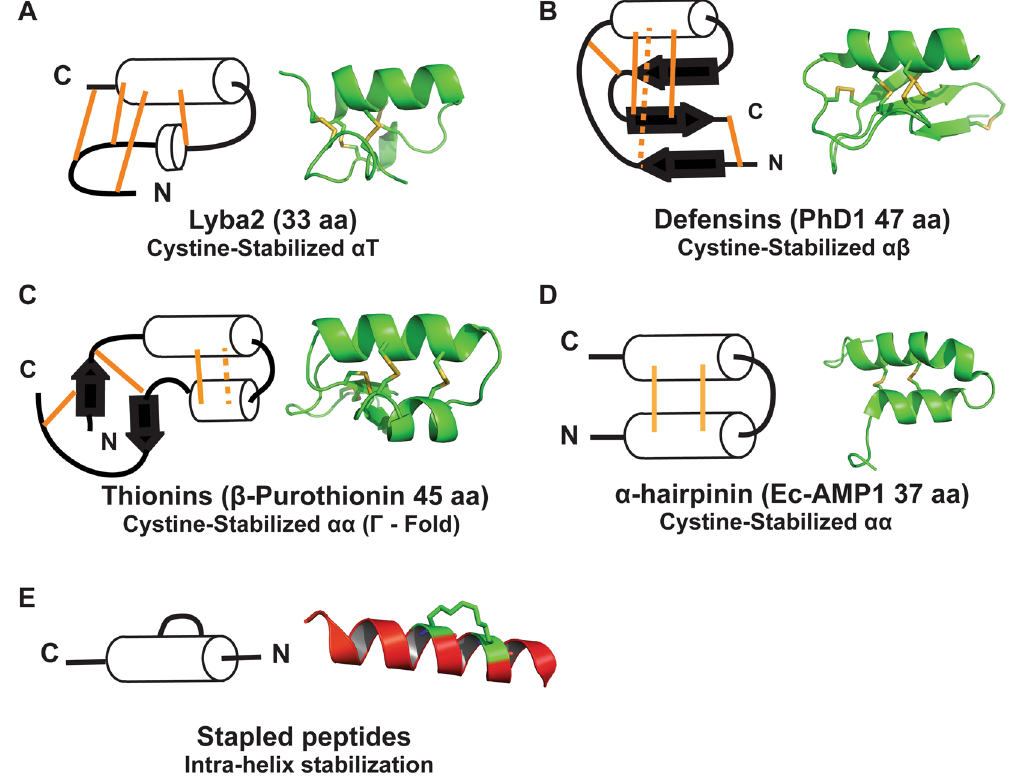
Figure 6. Cartoon and 3D structures of lybatide lyba2, defensin PhD1, thionin β -purothionin, α -hairpinin Ec-amp and stapled peptides. ( A ) Structure of lyba2. The N-terminal half of the peptide loops back along the ( α + π )-helix stabilizing it through hydrogen and disulfide bonds. ( B ) The structure of plant defensin contains a β 1-loop- α - β 2- β 3 pattern in the secondary structure, resulting in the CS αβ motif where the α -helix is stabilized by the anti-parallel β -sheet through disulfide bonds connecting the α -helix to the center strand of the β -sheet 57 . ( C ) The overall structure of thionins can be represented as by the Greek capital letter Г. The long arm is made up of antiparallel α -helices and the short arm contains a region of extended conformation and a short anti-parallel β -sheet. Disulfide crosslinking occurs within the two arms separately 18 . ( D ) The two helices in α -hairpinins are stabilized by two parallel disulfide bonds 58 . ( E ) The stabilization of the helical structure of stapled peptides occurs within the helix and is stabilized by hydrocarbon chains 59 . (PDB ID: ( B ) 1N4N, ( C ) 1BHP, ( D ) 2L2R, ( E ) 4MZK).